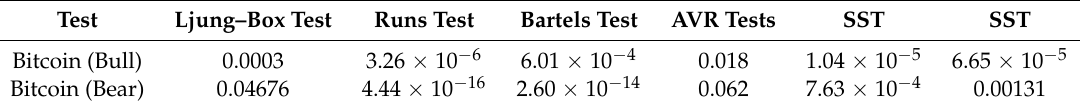
Table 4. Market-efficiency test for hourly returns of Bitcoin during bull and bear market.